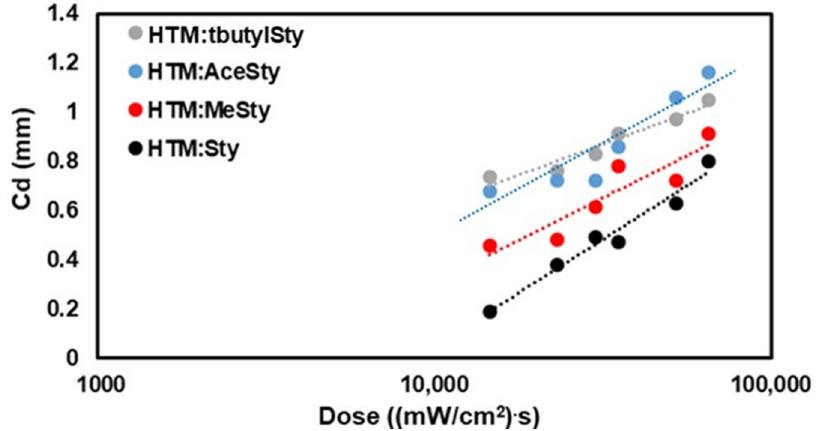
Figure 8. Working curve of HTM:Sty and HTM:Sty d (1:1 by mass) binary formulations using Dymax Visible light source where dotted lines indicating semi-logarithmic trend line fit to the data.